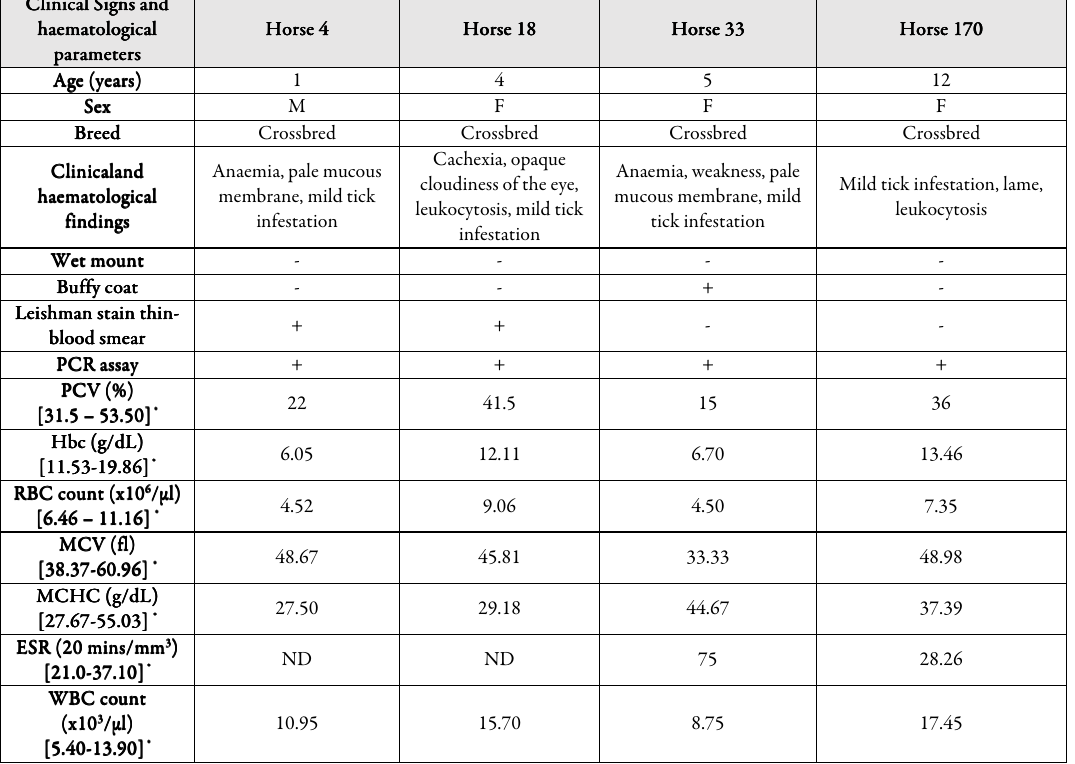
Table 5. Clinical and haematological findings of four horses with trypanosomosis Clinical Signs and